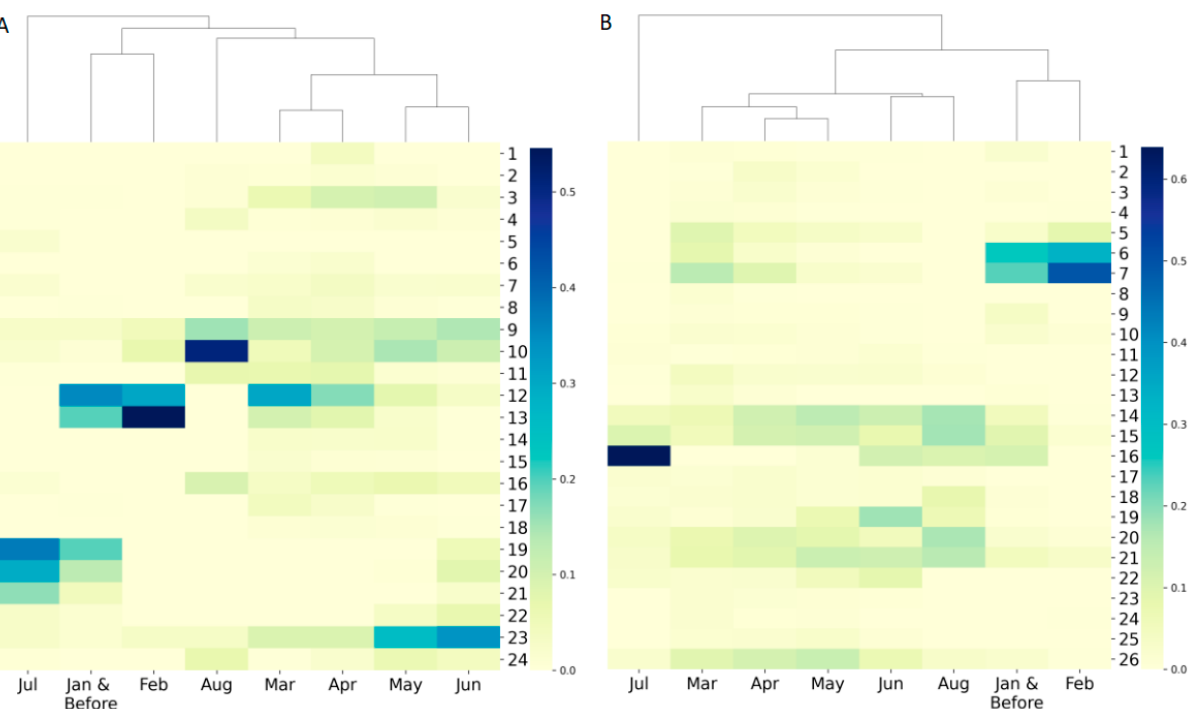
Figure 3. Hierarchical clustering of sequence frequency distribution in sequencing collection time period using ( A ) the GenBank dataset, and ( B ) the GISAID dataset. Each column represents a sequence collection time period shown as an x-axis tick label. Each row depicts a major clade marked by its clade number. The color palette indicates the sample frequency.